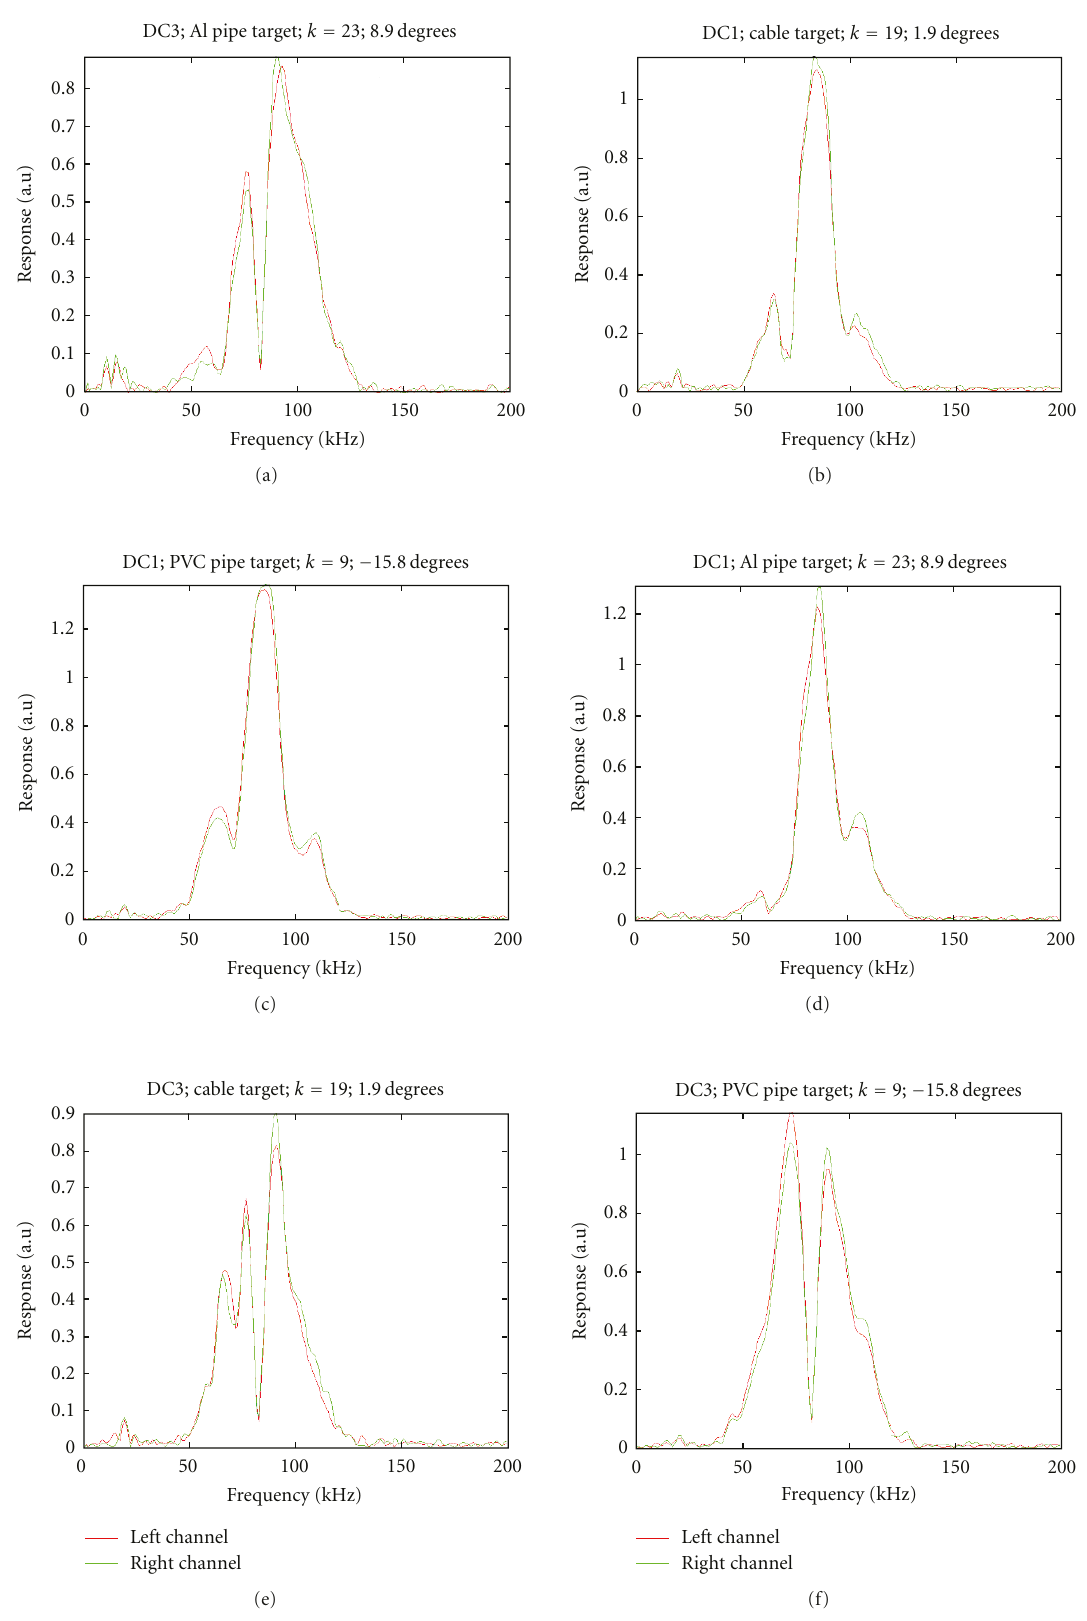
Figure 18: Target echo spectra using pulses DC1 and DC3 for a water-filled aluminium tube, a type C cable and an air-filled PVC